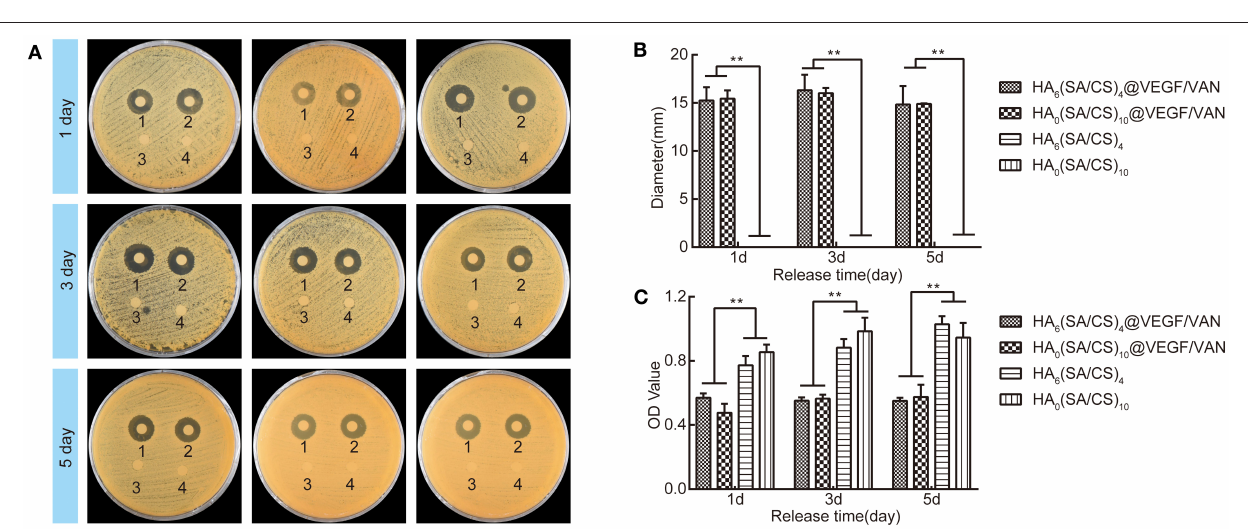
there was no significant difference in calcium ion release between the two